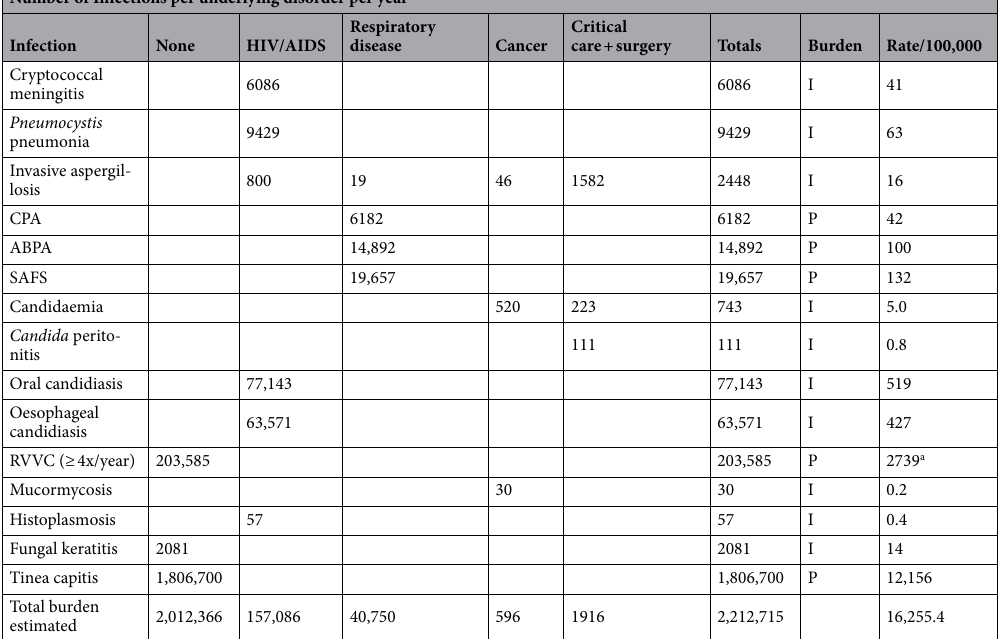
Table 1. Estimated burden of fungal diseases in Zimbabwe. I Incidence; P Prevalence; ABPA Allergic bronchopulmonary aspergillosis; SAFS Severe asthma with fungal sensitisation; CPA Chronic pulmonary aspergillosis; RVVC Recurrent Vulvovaginal Candidiasis a Rate among all